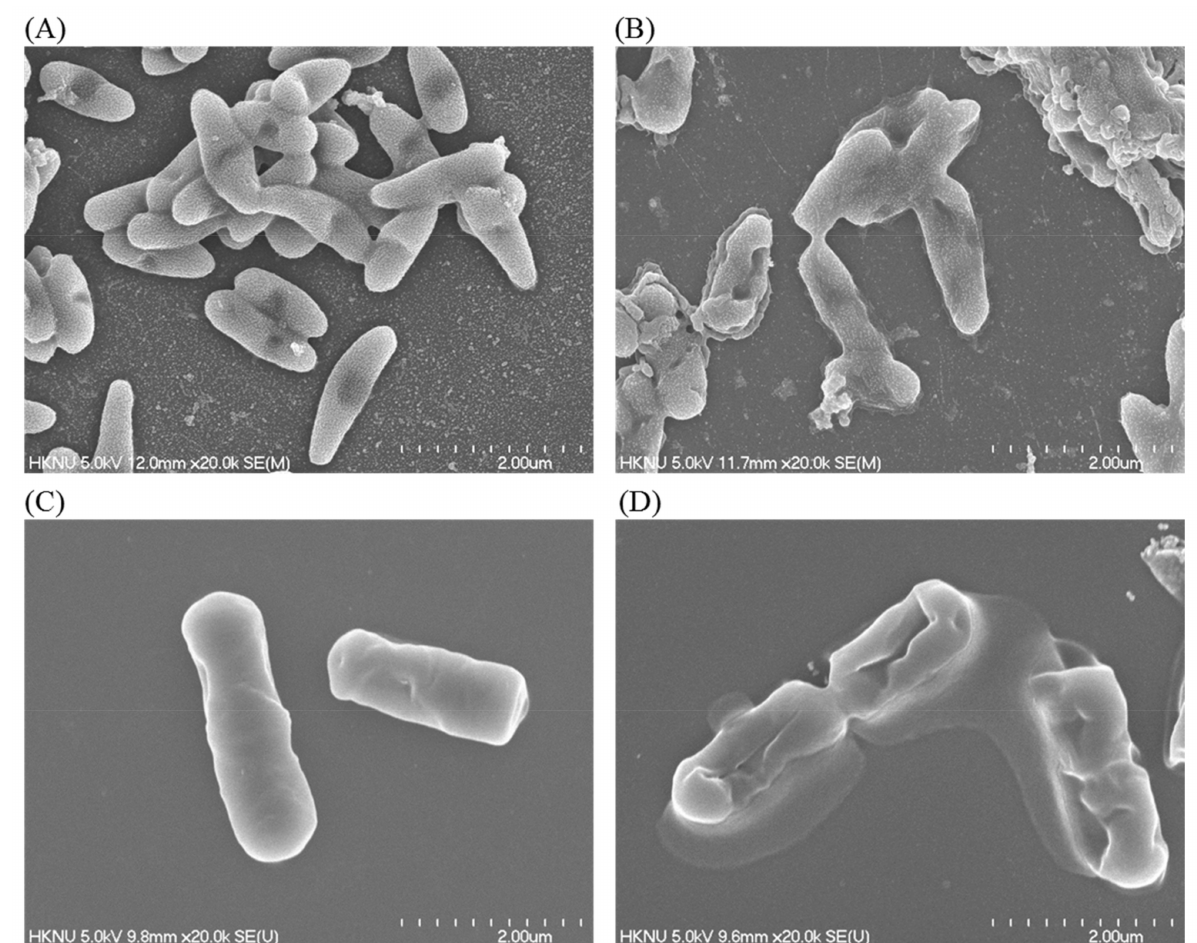
Figure 10. SEM images of normal P. aeruginosa cells ( A ), 1 × MBC AgNPs-treated P. aeruginosa cells ( B ), normal B. cereus cells ( C ), 1 × MBC AgNPs-treated B. cereus cells ( D